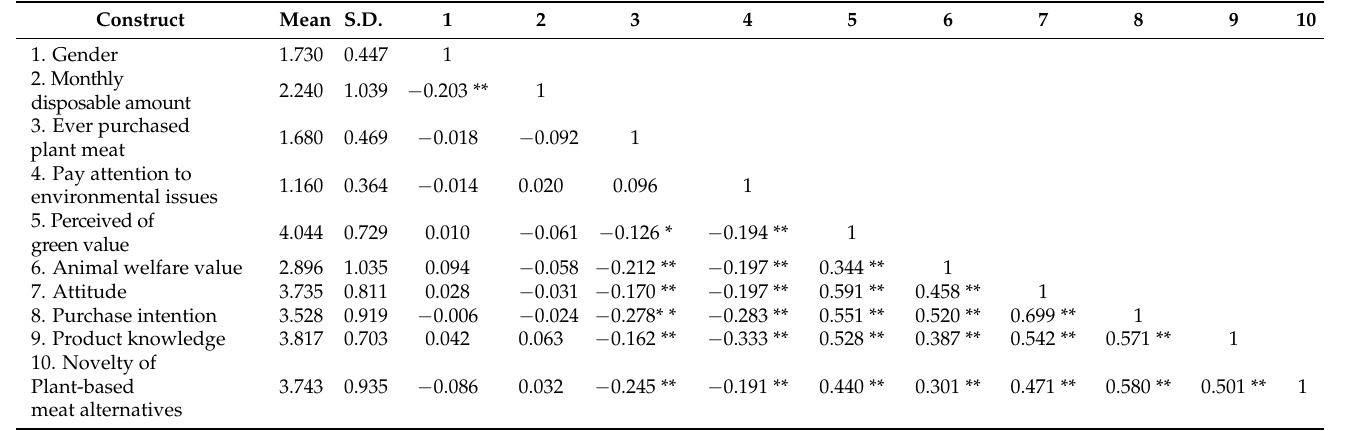
Table 4. Means, standard deviations, and correlations of